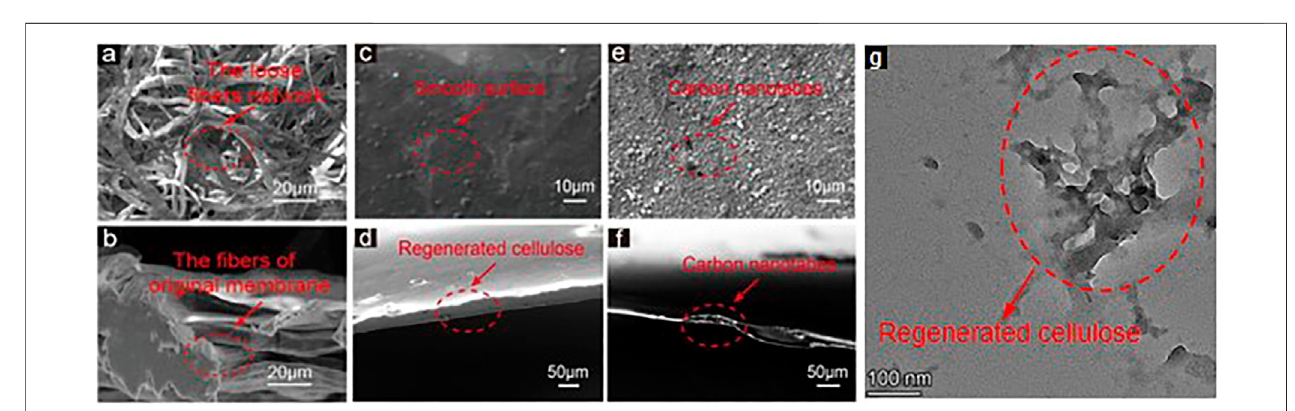
FIGURE2| SEMimagesofcross-sections: (A) Originalpaper; (C) Film-1; (E) FTFH;SEMimagesofthefracturesurface: (B) Originalpaper; (D) Film-1; (F) FTFH; (G) TEM image of regenerated cellulose.